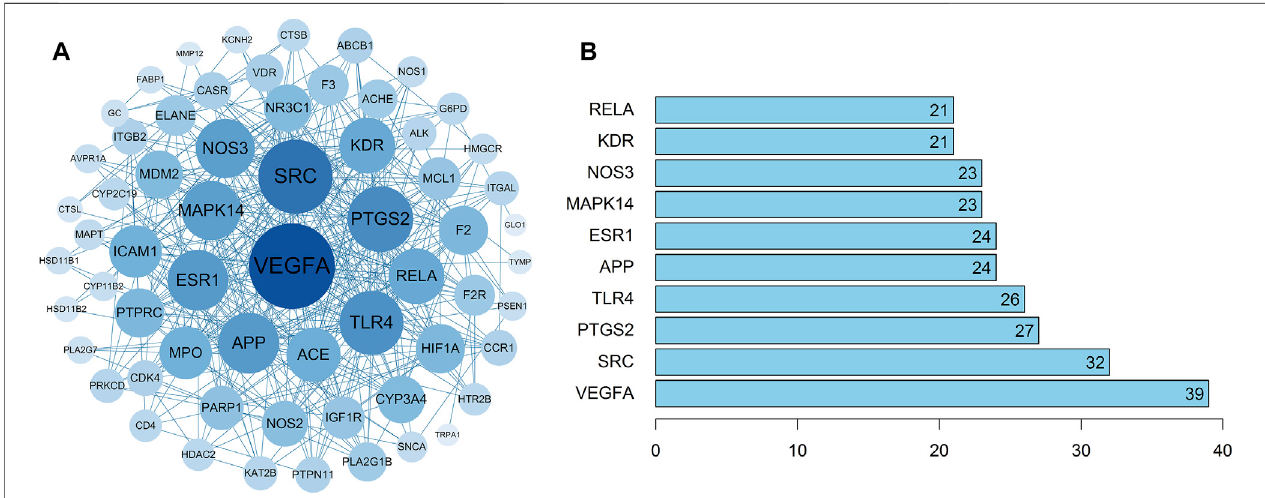
FIGURE 3 | The PPI network of the 63 intersecting targets (A) and the top ranked proteins (B) . The 63 intersecting targets were imported into Cytoscape to constructthe PPInetwork,the sizeandcolor ofthe nodesre fl ected thevalues ofdegree. Among them, thedegree valuesofVEGFA, SRC,PTGS2, TLR4and APPwere 39, 32, 27, 26, and 24, respectively, which were the key nodes of the network.